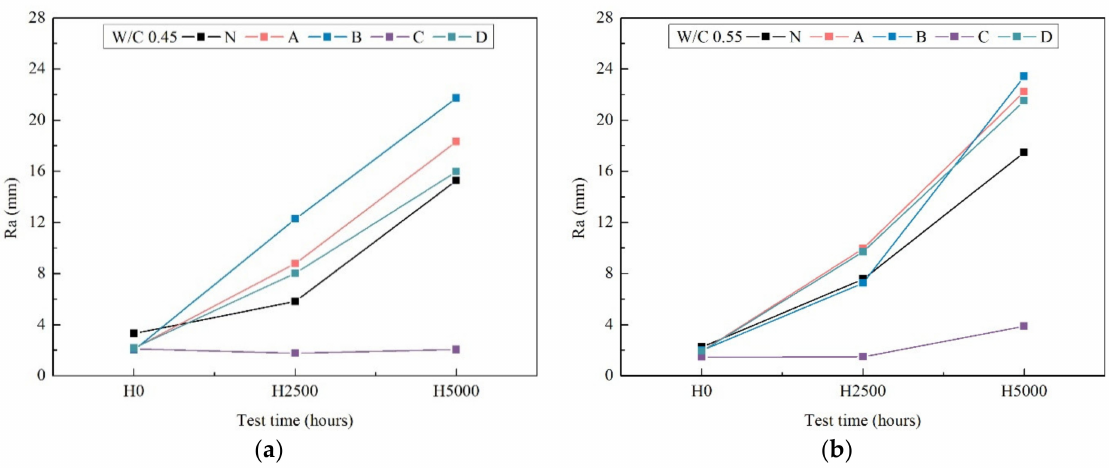
Figure 5. Roughness of surface coating after 0 h, 2500 h and 5000 h weathering of w/c ratio 0.45 ( a ) and 0.55( b